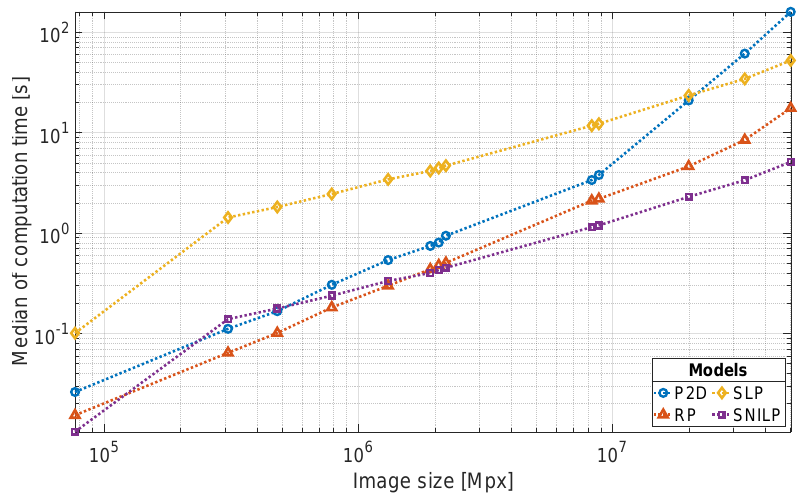
Figure 10. Comparison of computation times of the tested models for selected image formats and the degree of approximation polynomial s = 5. Exact information about chosen image formats is given in Table 5.